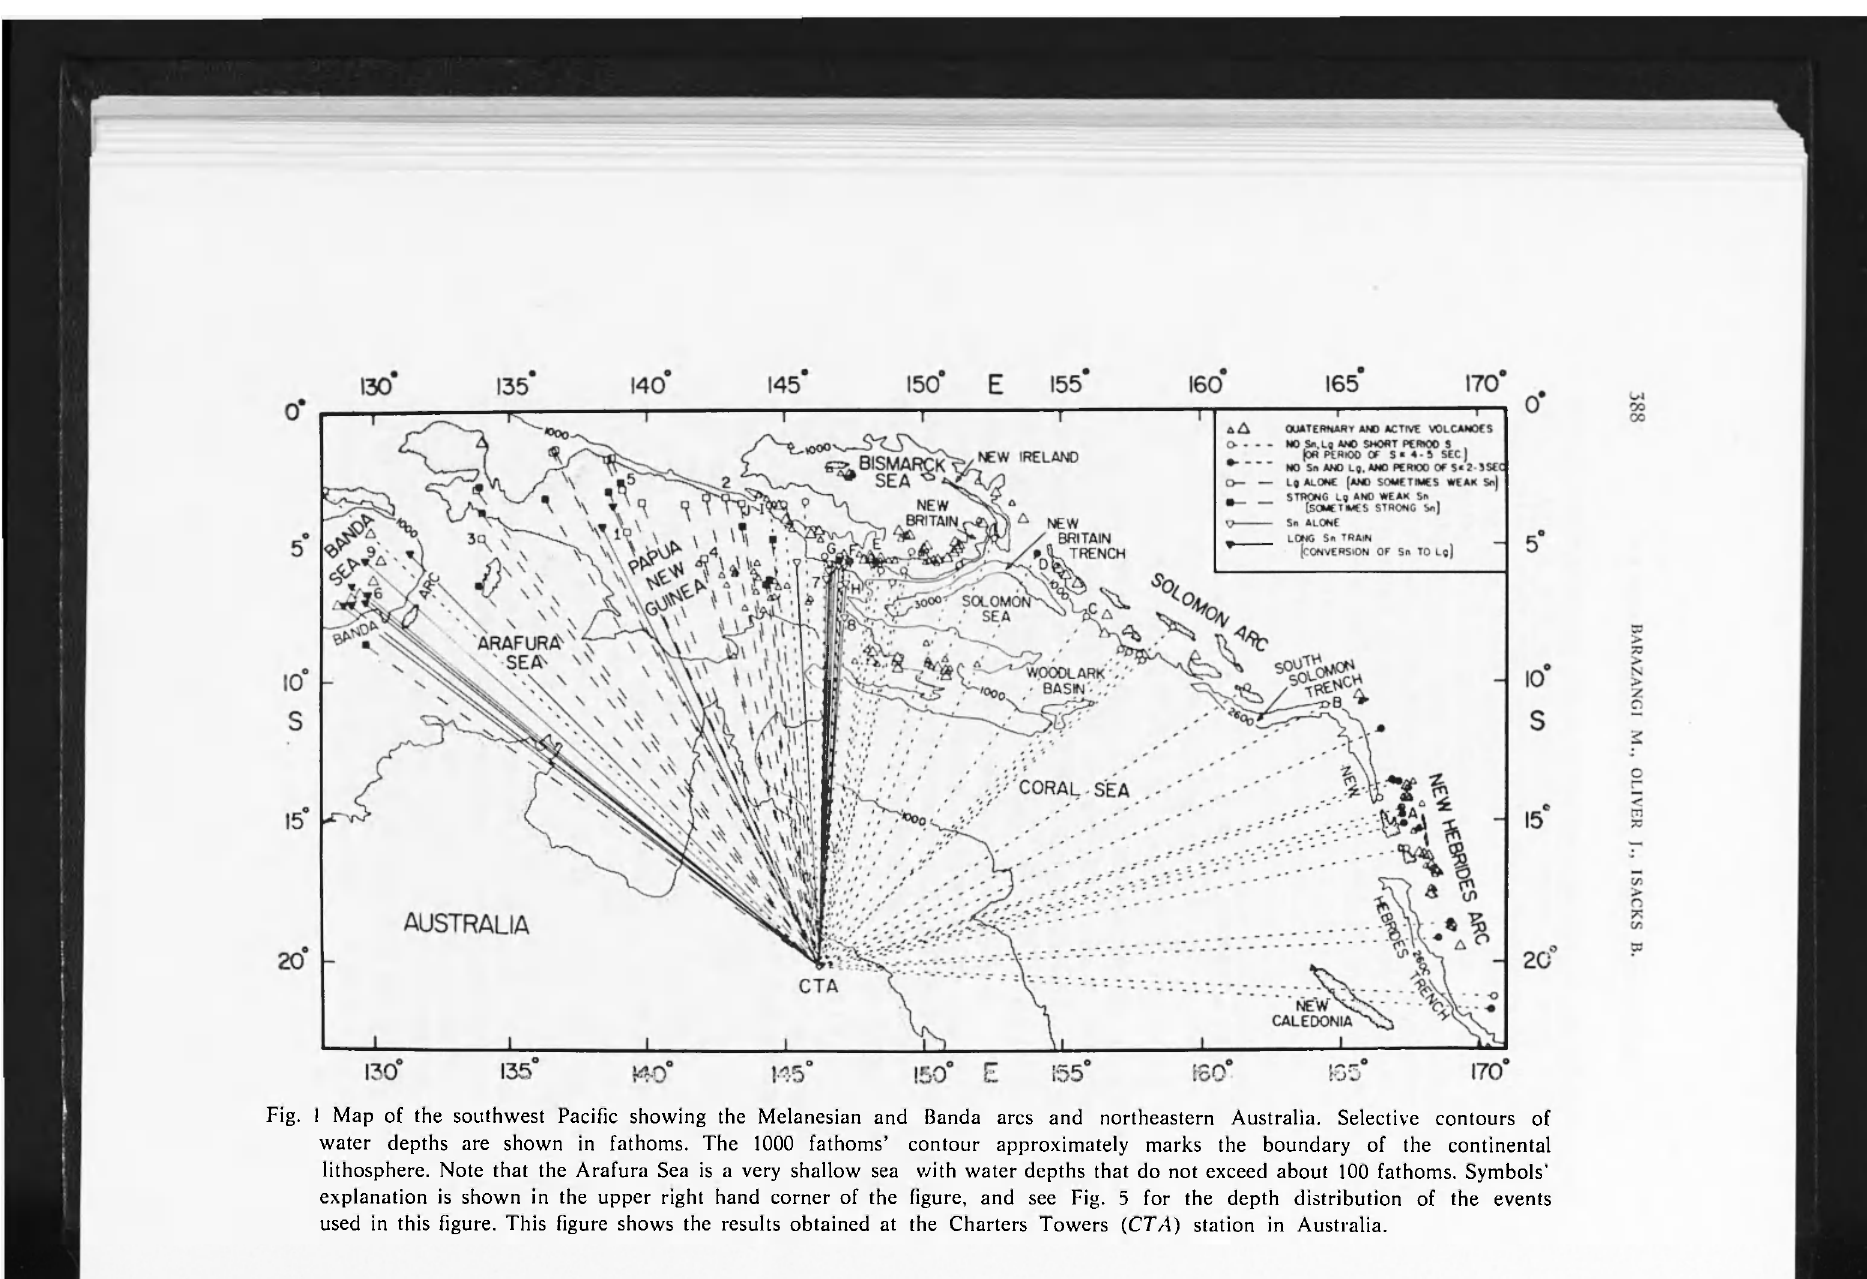
Fig. 1 Map of the southwest Pacific showing the Melanesian and Banda arcs and northeastern Australia. Selective contours of water depths are shown in fathoms. The 1000 fathoms' contour approximately marks the boundary of the continental lithosphere. Note that the Arafura Sea is a very shallow sea v/ith water depths that do not exceed about 100 fathoms. Symbols' explanation is shown in the upper right hand corner of the figure, and see Fig. 5 for the depth distribution of the events used in this figure. This figure shows the results obtained at the Charters Towers ( CTA) station in